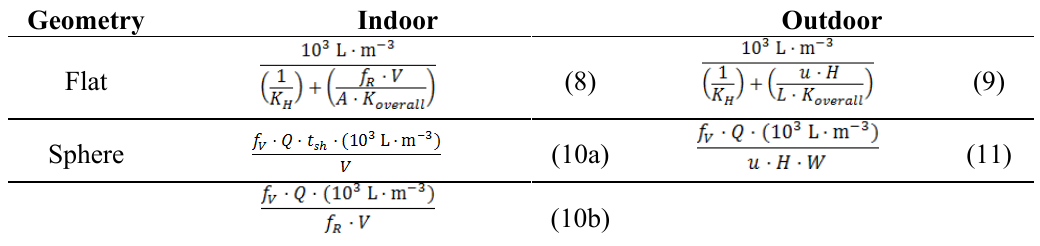
Table 2. Volatilization factor (VF) models (L∙m −3 ) for the types of scenarios